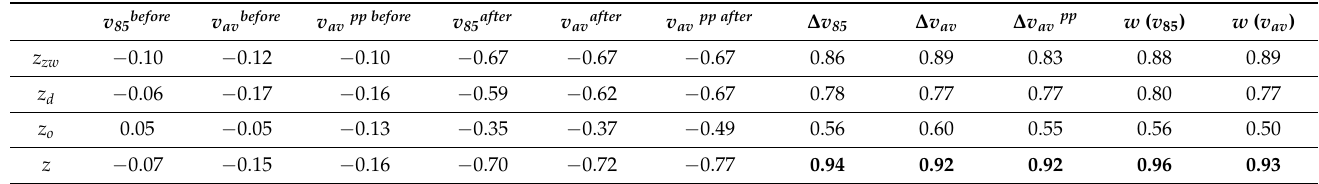
Table 3. Coefficients of correlation R between the quantitative measures and the chosen speed distribution parameters (excluding the additional sections No. 11 and No. 12, which had no chicanes